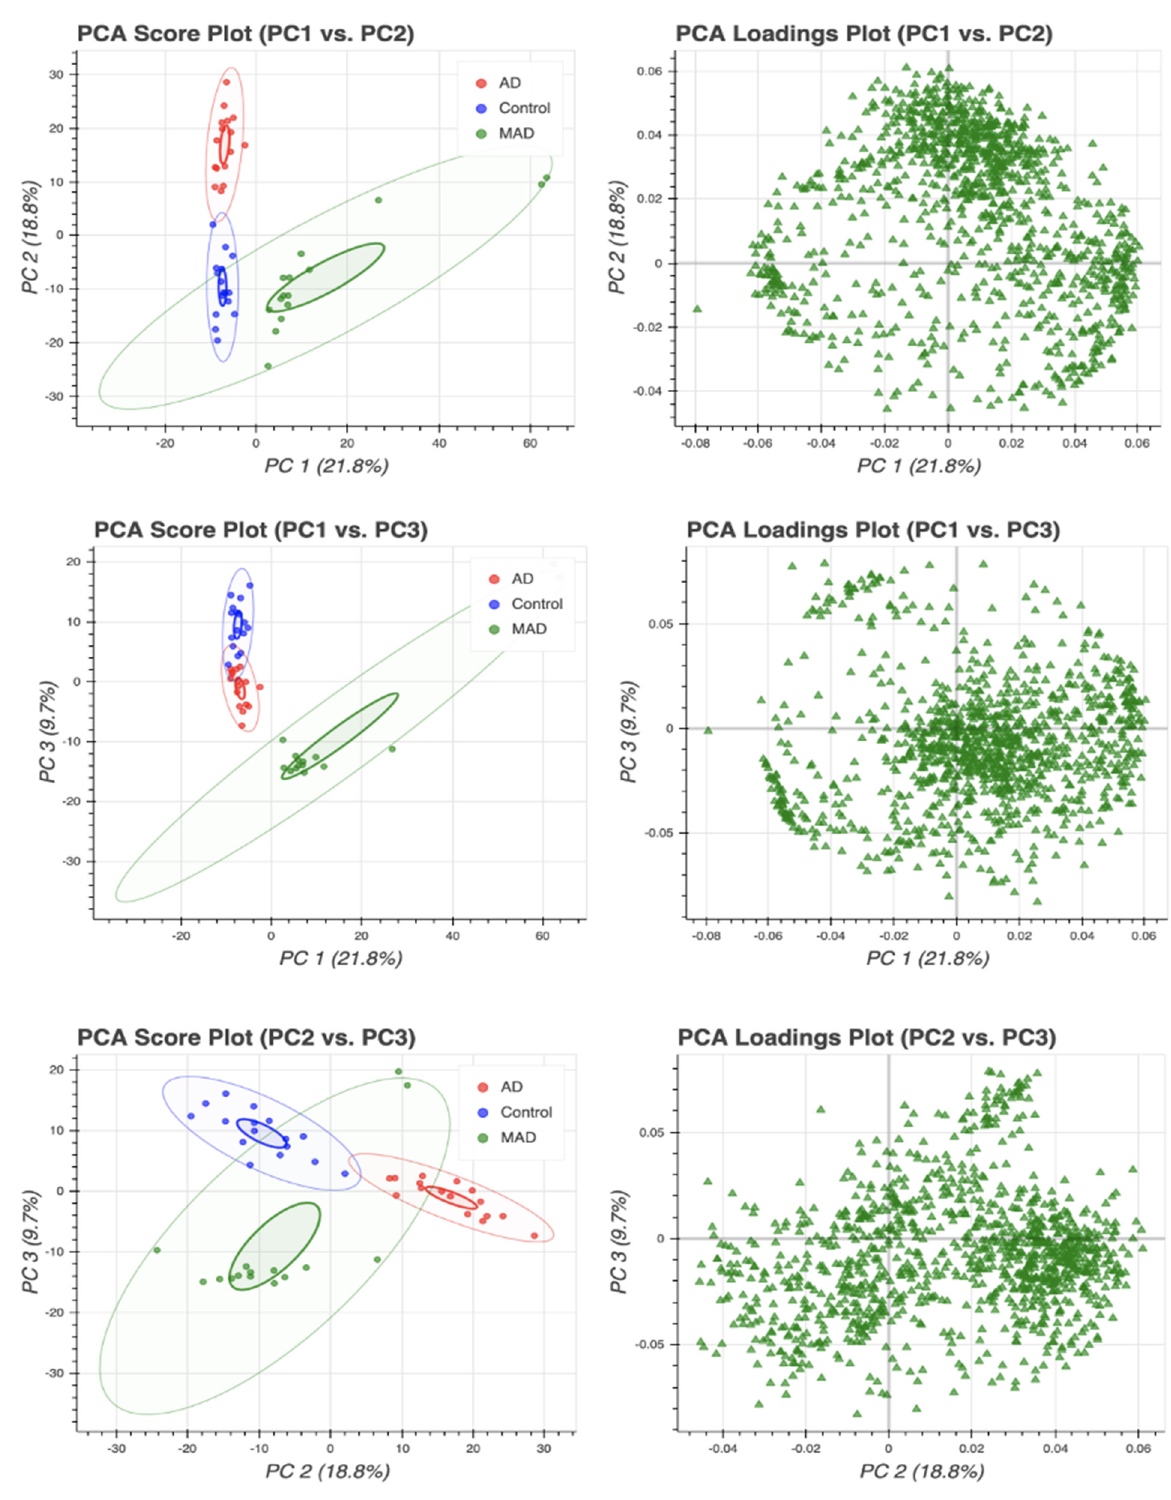
Figure 1. Principal component analysis (PCA) of the imputed and transformed data for outlier detection in control, mild AD, and AD groups was performed to check for any intrinsic variation. The following steps were followed to handle the data: standardization of the data; computing the covariance matrix; calculating the eigenvectors and eigenvalues; computing the principal components; and reducing the dimensions of the dataset.